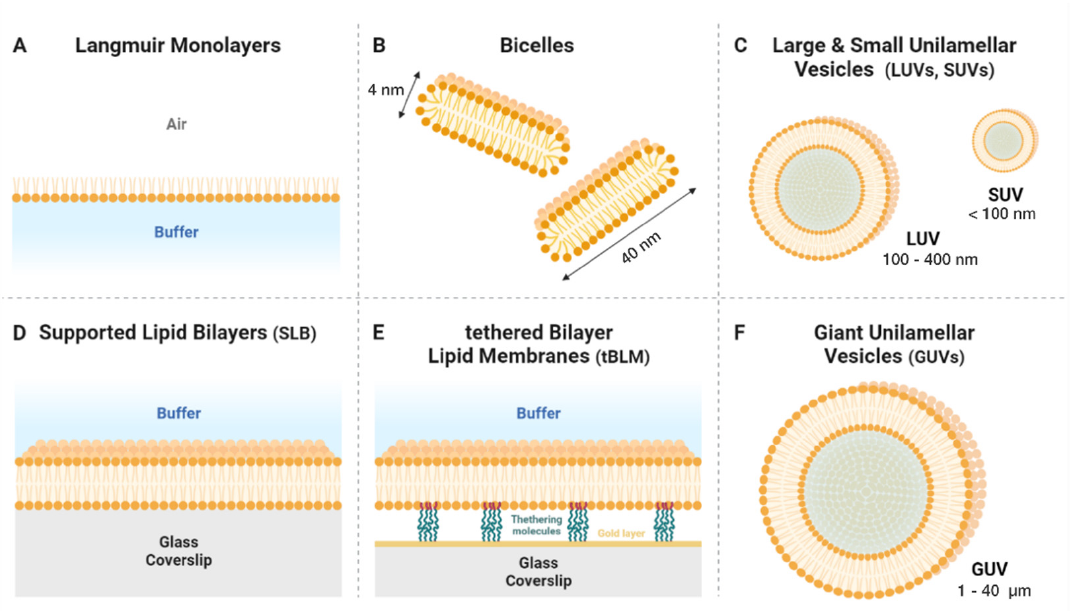
Figure 2. The different types of model membrane. ( A ) Langmuir monolayer, which consists in a thin monolayer of lipid at the air/water interface. ( B ) Bicelles are autoassembled droplets of lipids in a polar solvent. Polar heads of lipids are exposed to solvent while apolar acyl chains face each other. ( C ) Large and small unilamellar vesicles are single lipid bilayers separating two polar media vesicles with a diameter of less than 500 nm. ( D ) Supported lipid bilayers (SLBs) are large, flat, single bilayers facing a solid support on one side (mica, glass, etc.) and a liquid buffer on the other side. ( E ) Tethered-bilayer lipid membranes are adaptations of SLBs, displacing the bilayer from the solid support in order, for both faces of the bilayer, to be exposed to the same liquid buffer. ( F ) Giant unilamellar vesicles are the most appropriate membrane model to mimic cell plasma membranes. They consist in a single lipid bilayer separating two (identical or not) liquid media.